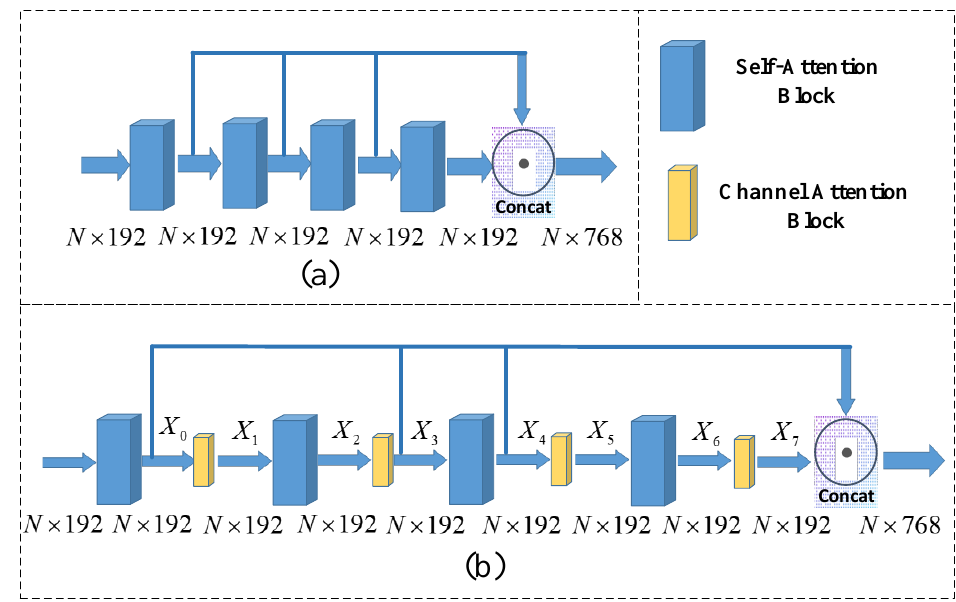
Figure 4. ( a ) Initial TMFR structure; ( b ) improved structure.